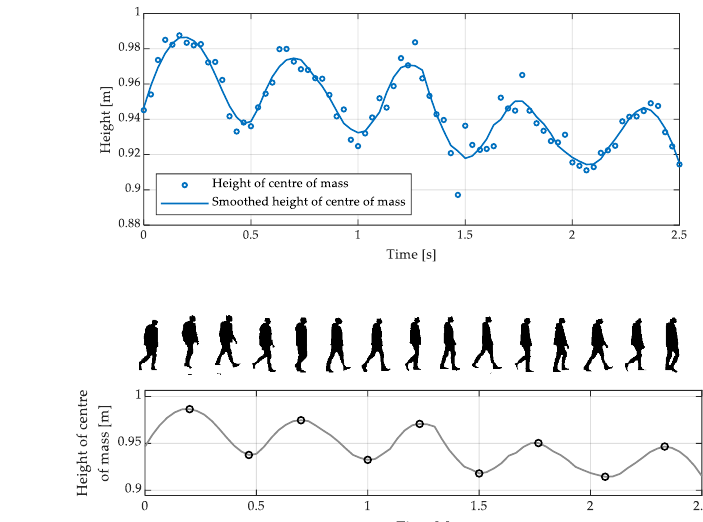
Figure 4. ( a ) Exemplary estimates of the height of the examined person’s centre of mass during walking, obtained using a depth sensor, and the results of their smoothing using a Savitzky-Golay filter; ( b ) an exemplary dependence of the height of a walking person’s centre of mass on time, with its local extrema indicated with circles and the corresponding silhouettes of that person extracted from the depth images.